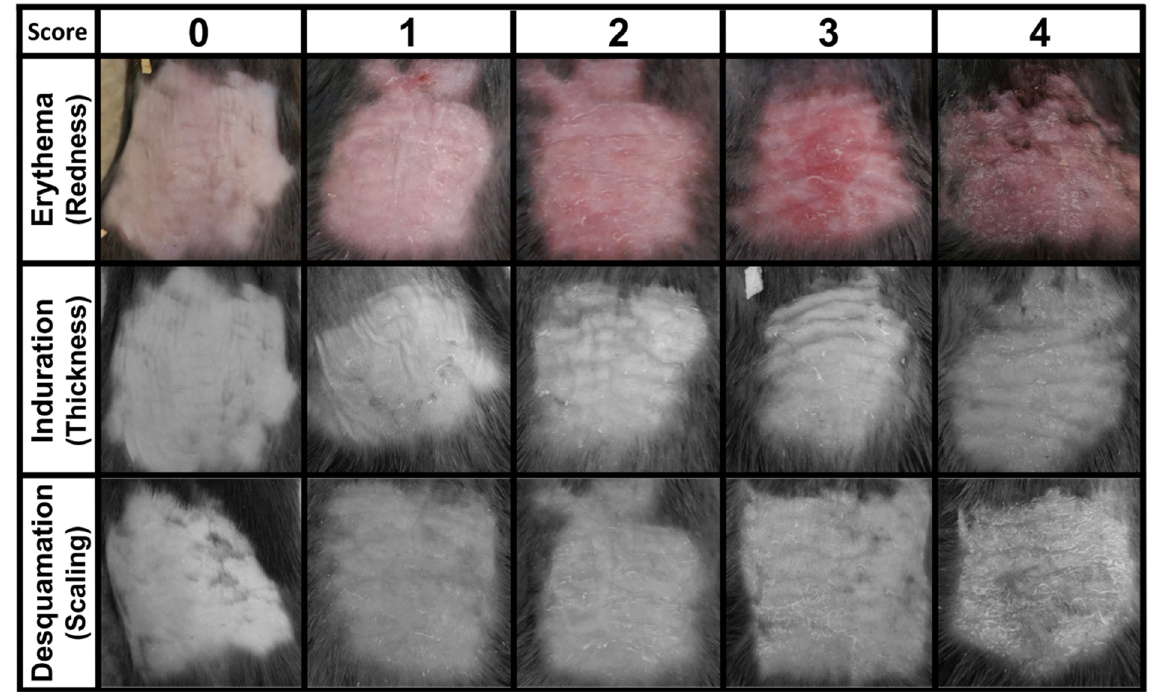
Figure 2. Mouse PASI scoring system. To determine overall skin inflammation during plaque psoriasis, erythema, induration,